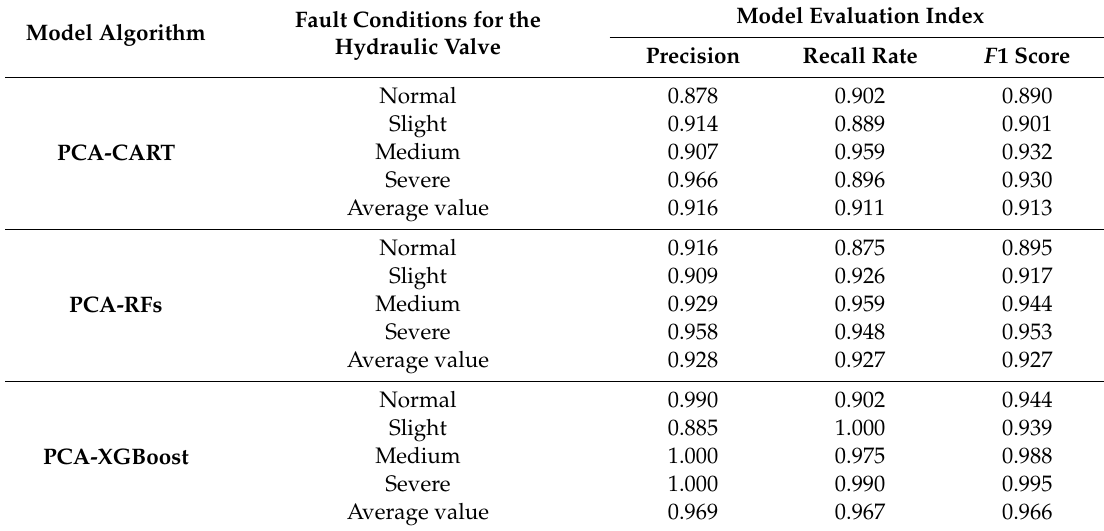
Table 6. Model evaluation